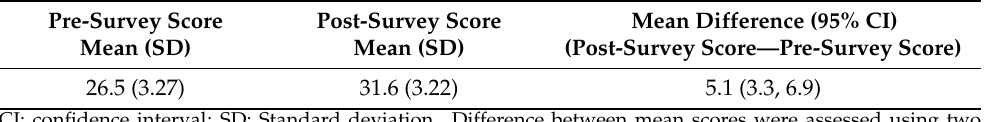
Table 2. Differences between the pre-survey score and post- survey score among all 55 participants.